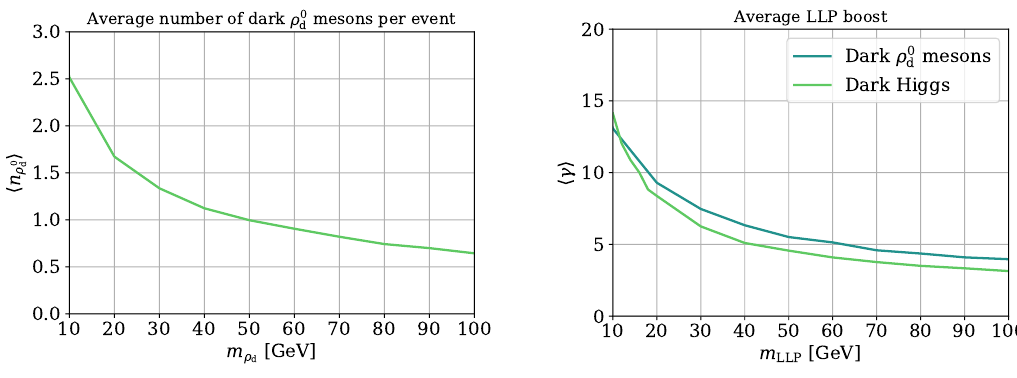
mesons in a dark shower as a function of the dark d mesons and dark Higgs bosons as a function of their mass. d